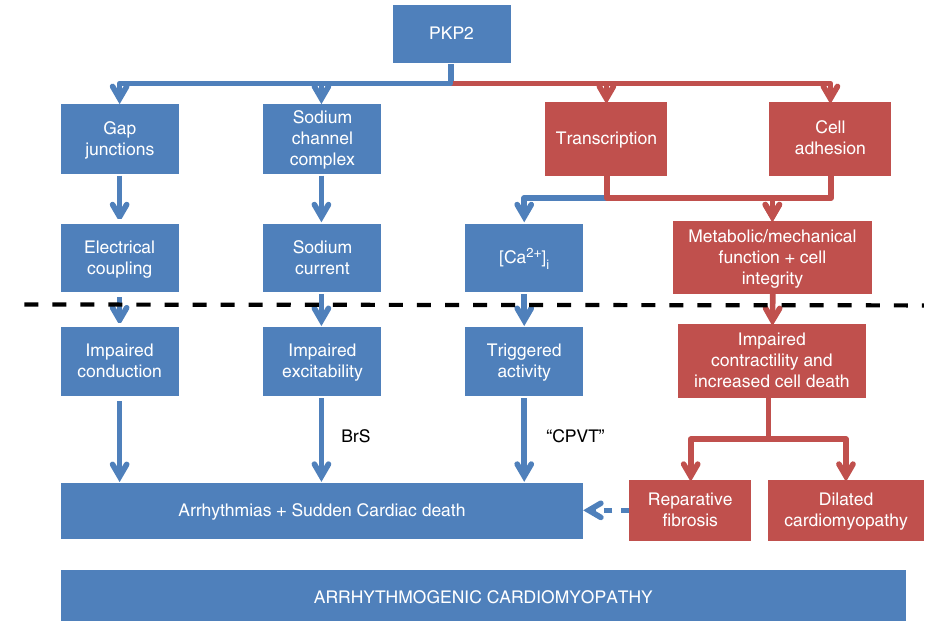
Fig. 10 Diagrammatic representation of the function of PKP2 in the adult heart. PKP2 scaffolds a signaling node at the intercalated disc. From that position, it covers four known functions: Maintains intercellular coupling and sodium channel function, modulates transcription, and facilitates cell – cell adhesion. In the present study, we show that transcriptional regulation impacts on [Ca 2+ ] i homeostasis. These functions are necessary for normal electrical and mechanical function. Loss or mutations in PKP2 (signaled by the black horizontal dotted line ) could independently impair electrical ( blue ) or mechanical ( red ) function. A predominant effect in one of these descending branches would yield either an electrical phenotype (resembling Brugada syndrome — BrS — or resembling catecholaminergic polymorphic ventricular tachycardia — CPVT), a mechanical phenotype (e.g., dilated cardiomyopathy) or a combination of both, which would yield the “ classic ” phenotype of